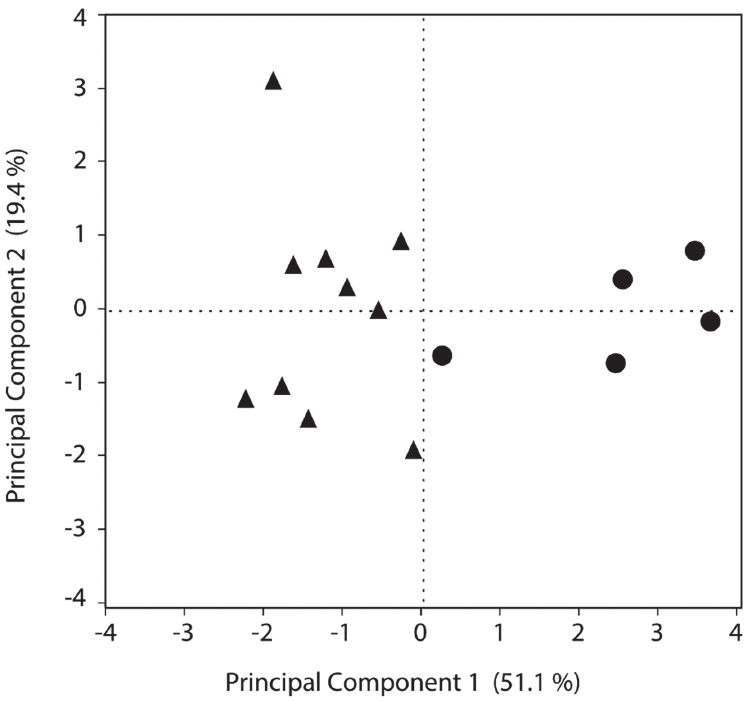
Fig 5. Score plot for the two main principal components obtained in the PCA analysis. Data points are separated by colonies reared on the restricted (circles), and